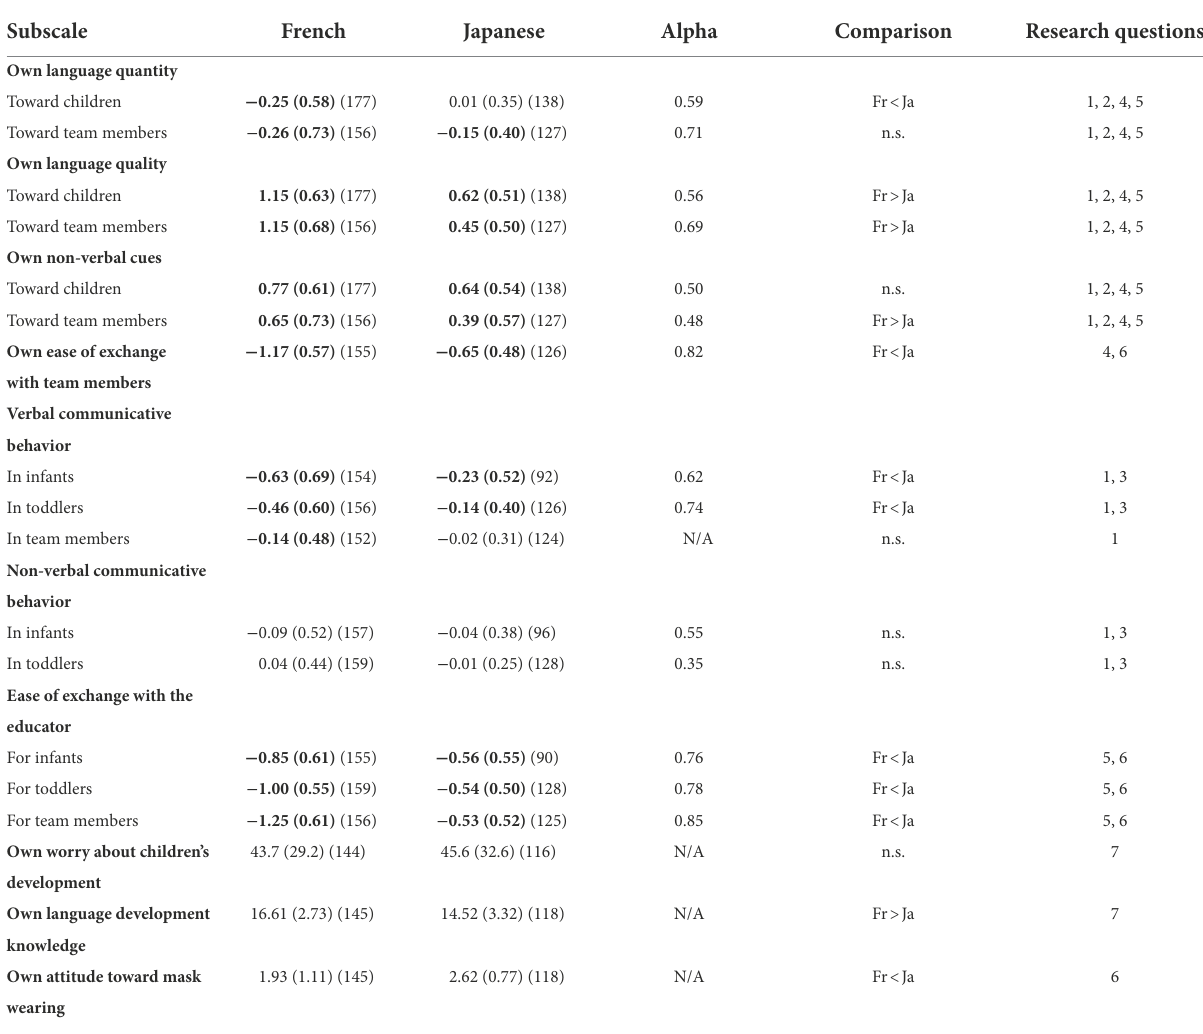
TABLE 3 Means, SDs, and Cronbach’s Alpha for each subscale. Subscale